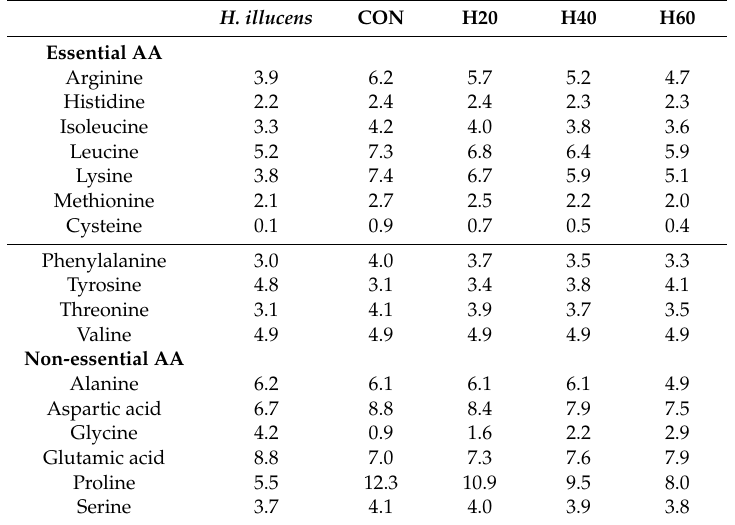
Table 2. Amino acid (AA) profile (% of protein) of Hermetia illucens larva meal and experimental diets.